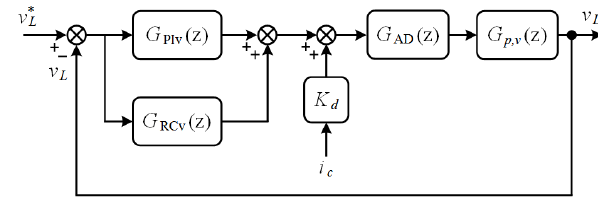
Figure 9. Block diagram of the voltage control in SA mode.